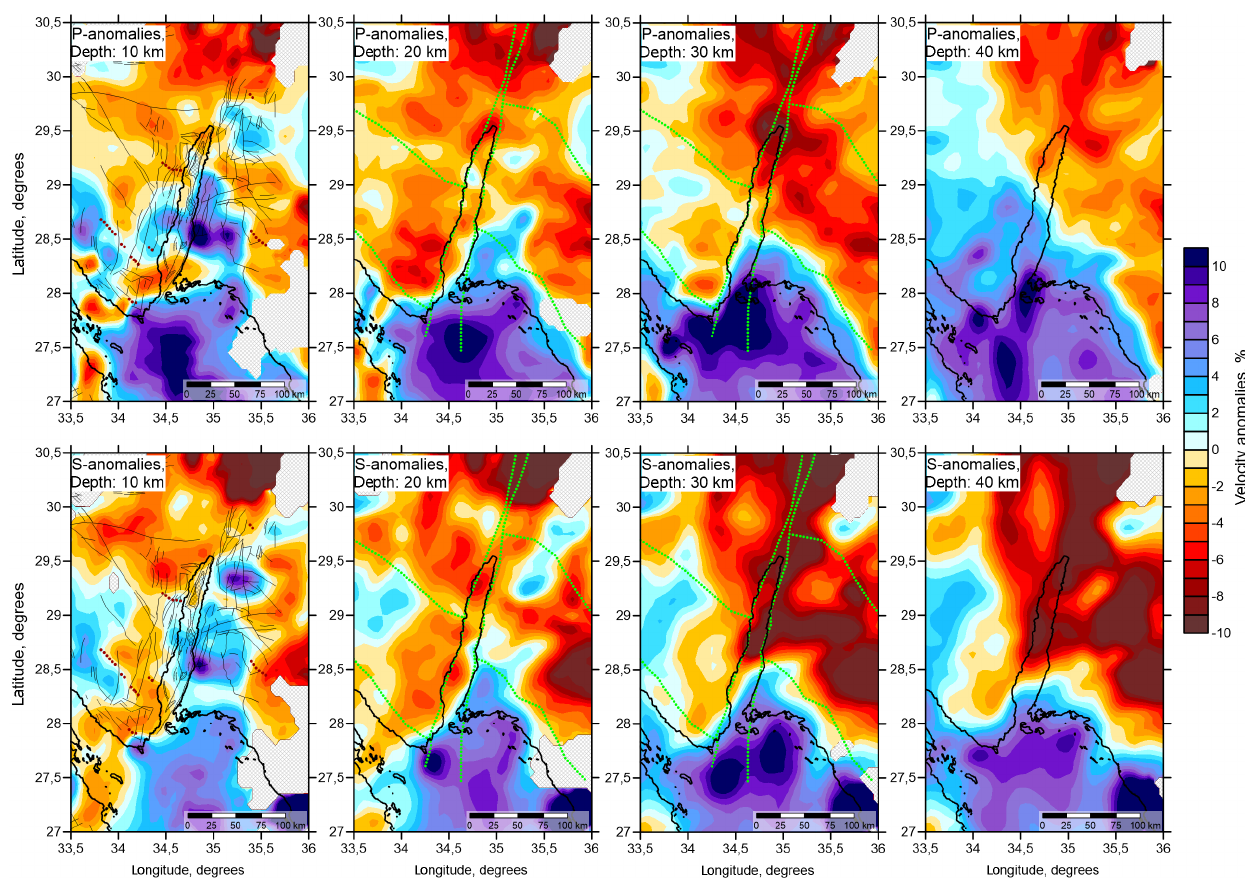
Figure 7. P and S anomalies resulting from the observed data inversion in four horizontal sections. At 10km depth, major tectonic units (the same as in Fig. 1b) are shown. In sections at 20 and 30km depth, the reference lines marking the displacements along the DST are depicted by green dotted